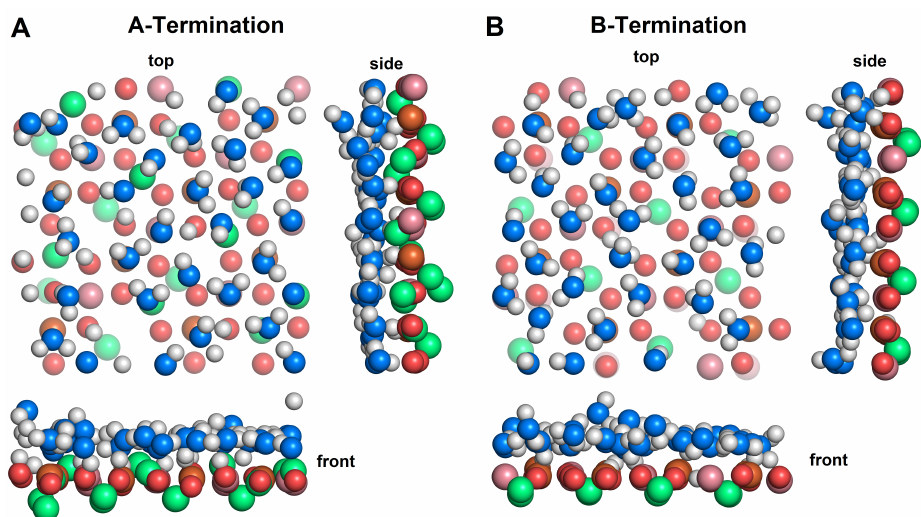
Figure 3. Snapshots of final configurations of each simulation. Fe 3+ (tet) : green, Fe 3+ (oct): brown, Co 2+ (oct) : purple, slab oxygens: red, water/hydroxide oxygen: blue, hydrogen: white. Greyed-out atoms are located in lower layers.